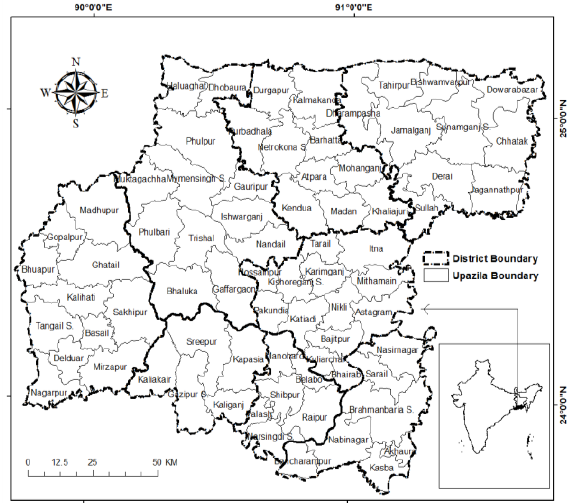
Figure 1: The study area, covering the northeastern part of